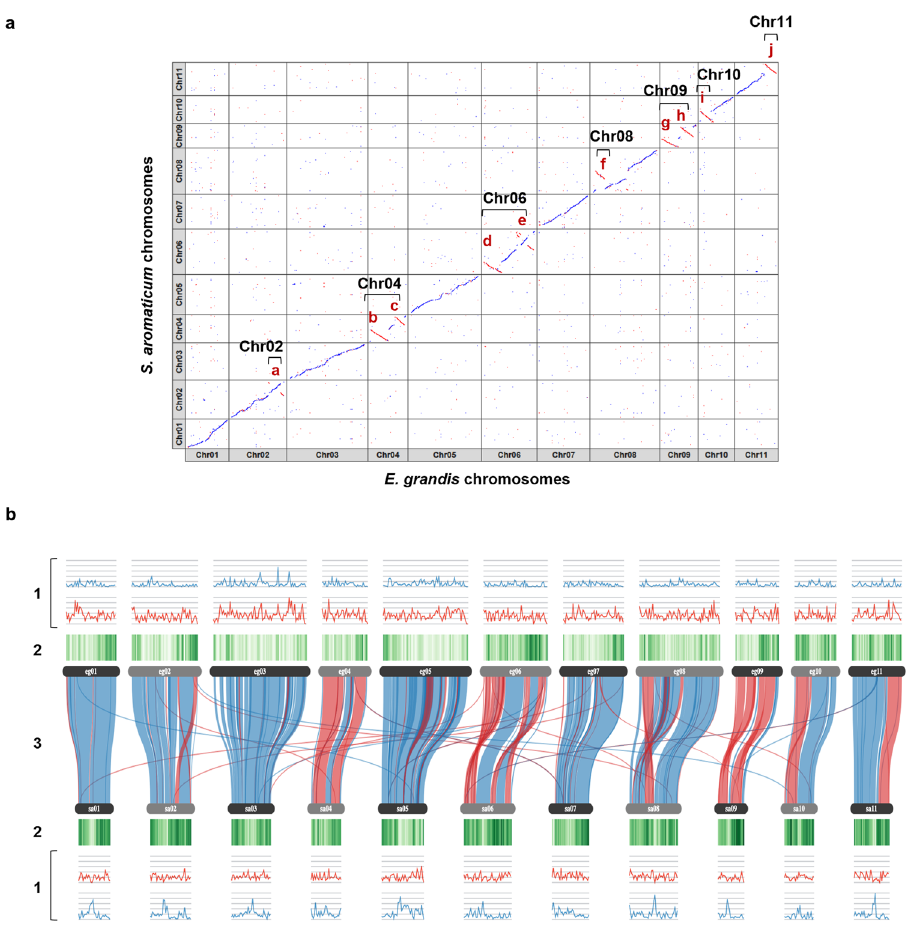
Fig. 1 Comparative analysis of the Syzygium aromaticum genome with Eucalyptus grandis genome. a DNA alignment of the S. aromaticum and E. grandis 11 chromosomes. The alignment of the DNA sequences of E. grandis and S. aromaticum chromosomes (Chr) is shown in blue. The main intrachromosomal rearrangements (a to j) are indicated in red. b SynVisio representation of E . grandis (eg) and S . aromaticum (sa) chromosomes showing the (1) distributions of Copia (red) and Gypsy (blue) LTR retrotransposons; (2) density of protein-coding genes; and (3) alignment of protein syntenic blocks between the two Myrtaceae